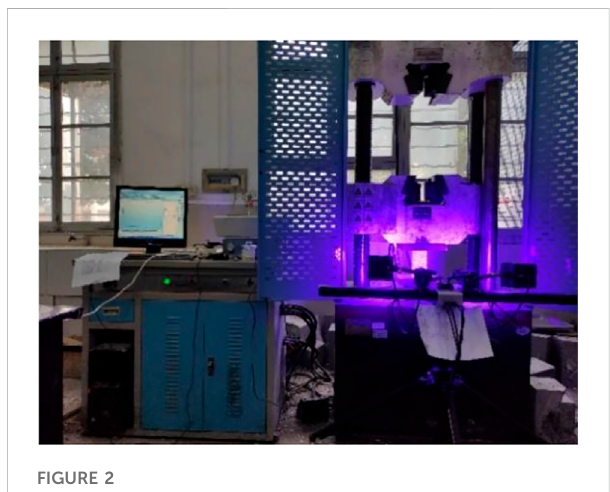
FIGURE 2 Test instrument physical